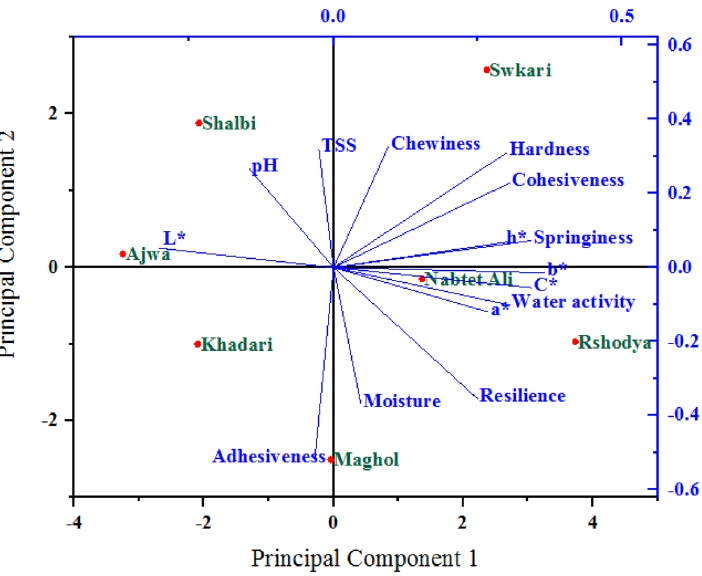
Figure 9. A biplot diagram based on PC1 and PC2 shows similarities and dissimilarities in relationships among the measured variables across different varieties of palm dates under after SDBD